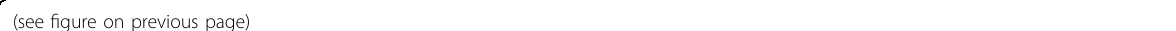
Fig. 4 S100A16 promotes EMT in the fi brotic kidney. a – d Representative immunoblotting and corresponding semi-quanti fi cation of E-cadherin, N-cadherin, vimentin, and S100A16 protein expression in obstructed kidneys of wild type and S100A16 Tg mice. * p < 0.05, ** p < 0.01 vs. wild type sham groups; # p < 0.05, ## p < 0.01. e – h . Representative immunoblotting and corresponding semi-quanti fi cation of E-cadherin, N-cadherin, vimentin, and S100A16 protein expression in obstructed kidneys of wild type and S100A16 + / − mice. * p < 0.05, ** p < 0.01 vs. wild type sham grou p s; # p < 0.05, ## p < 0.01. i – k Immunohistochemical staining of E cadherin , N-cadherin, vimentin in the obstructed kidneys of WT, S100A16 Tg , and S100A16 + / − mice. Scale bar = 50 μ m.